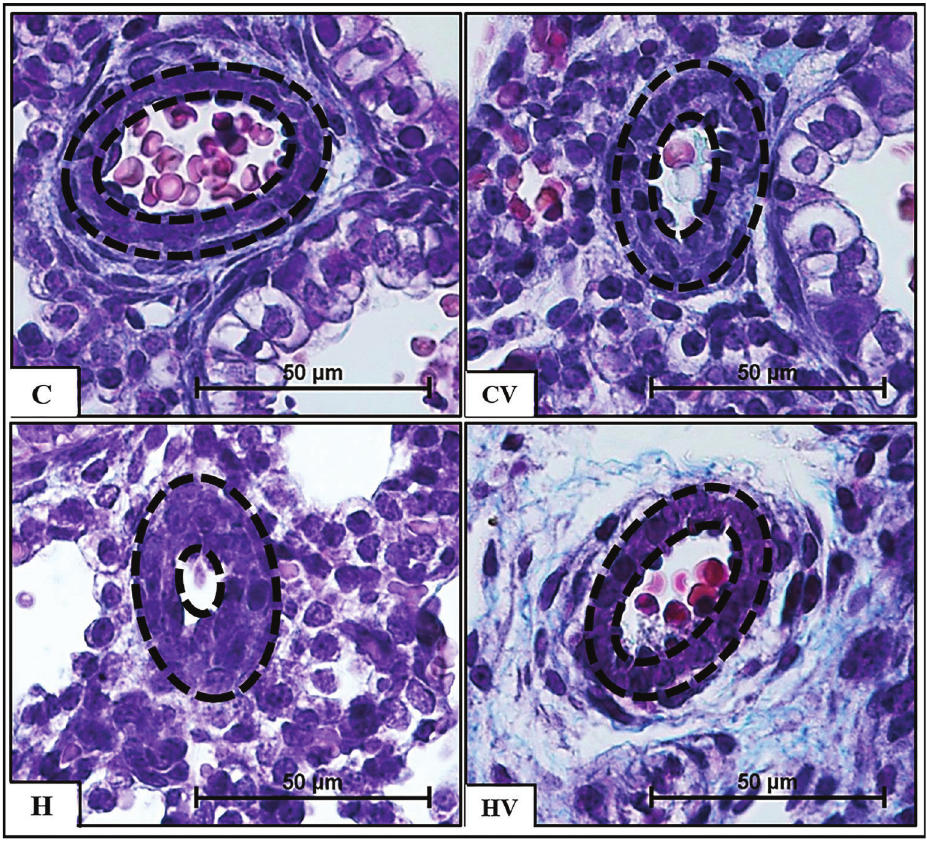
Figure 2. Photomicrographs of Masson ’ s trichrome-stained arterioles. Dashed lines refer to the arteriole wall thickness. C: control; CV: control submitted to mechanical ventilation. H: hypoxia; HV: hypoxia submitted to mechanical ventilation. Magni fi cation, 400 (cid:1) ; bar, 50 m m. Table 2. Mean wall thickness (MWT) of preacinar arterioles with diameter of 30 – 60 m m.